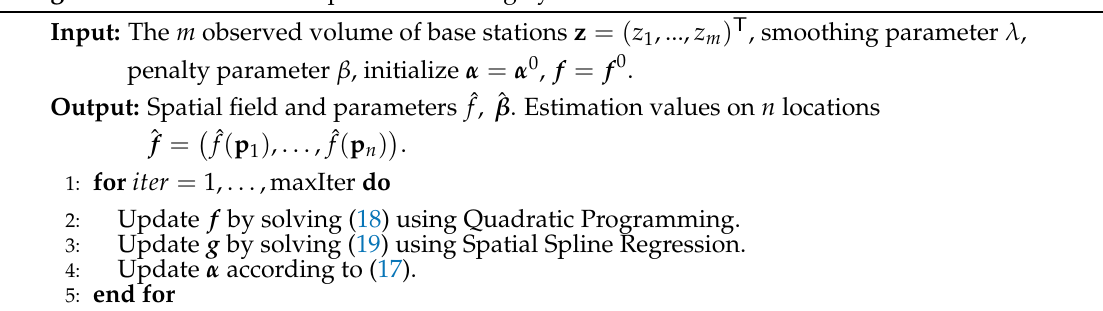
Algorithm 1: Constrained Spatial Smoothing by